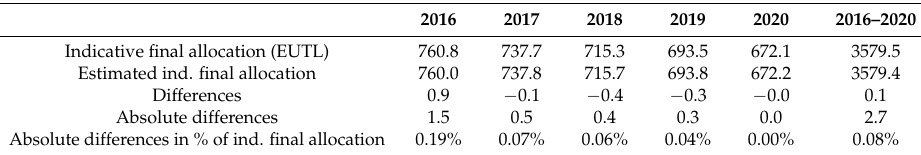
Table A1. Validation of the data